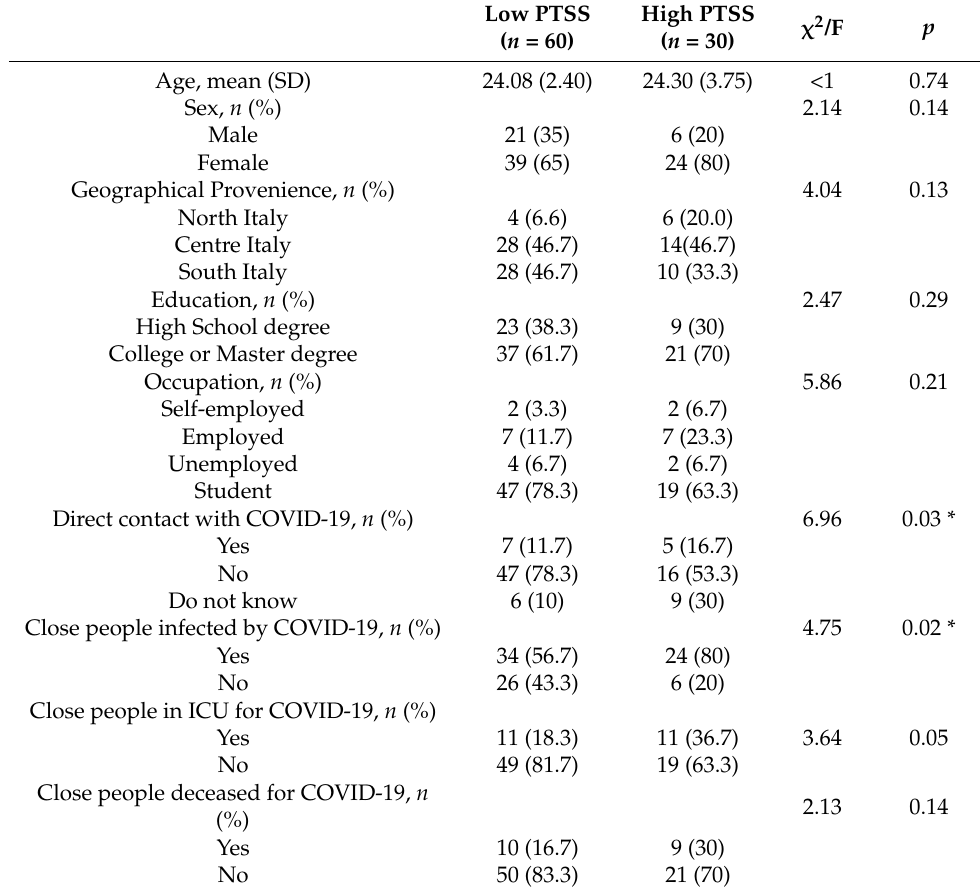
Table 1. Demographic and COVID-19 related variables of the two groups of